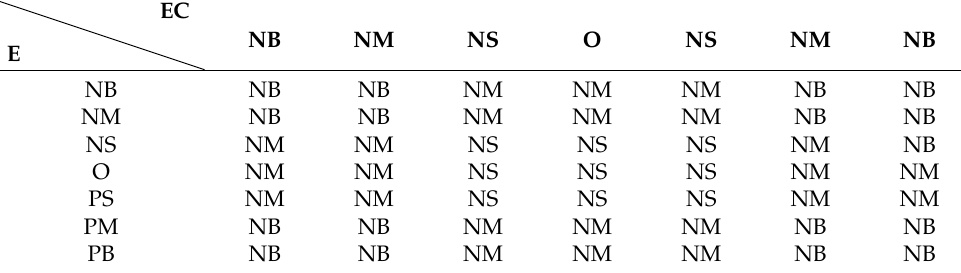
Table 1. Fuzzy rule tables based on fuzzy